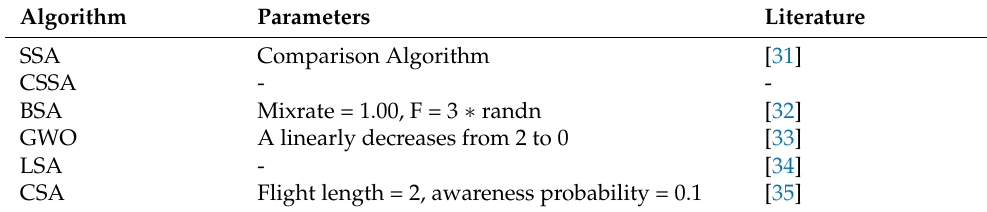
Table 3. Parameter settings for all